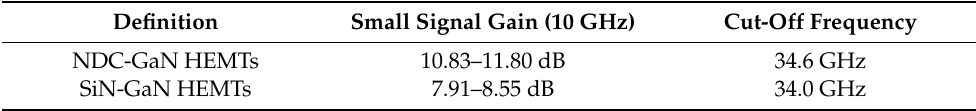
Table 1. Small signal gain and cut-off frequency characteristics.